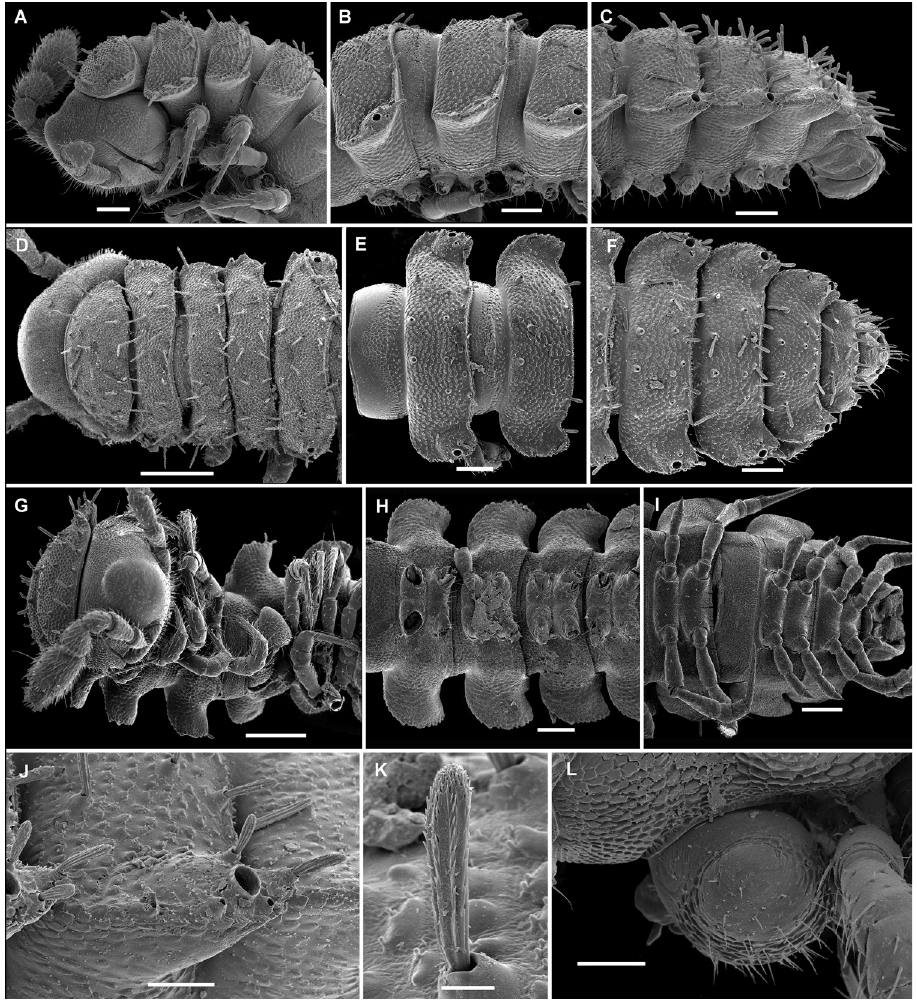
Figure 19. Hemisphaeroparia bamboutos sp. n., SEM micrographs of ♂ paratype A, D, G anterior part of body, lateral, dorsal and ventral views, respectively B, E, H midbody segments, lateral, dorsal and ventral views, respectively C, F, I posterior part of body, lateral, dorsal and ventral views, respectively J midbody paratergum, lateral view K tergal seta, lateral view J midbody segment, caudal view L gonopods in situ, lateral view. Scale bars: 0.2 mm ( D, G, I ), 0.1 mm ( A–C, E, F, H ), 0.05 mm ( J, L ), 0.01 mm ( K